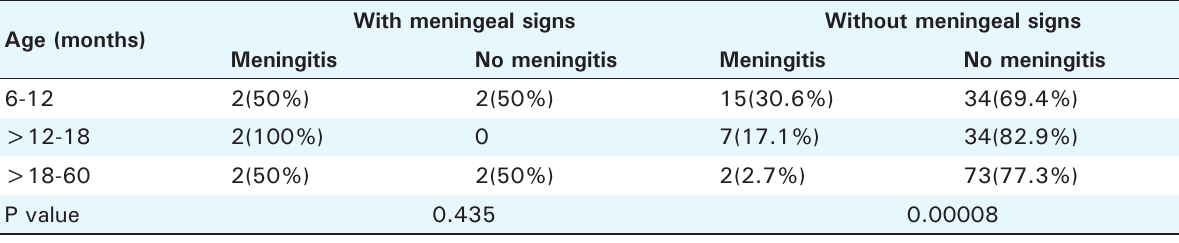
Table 3. Meningitis in different age groups with/without meningeal